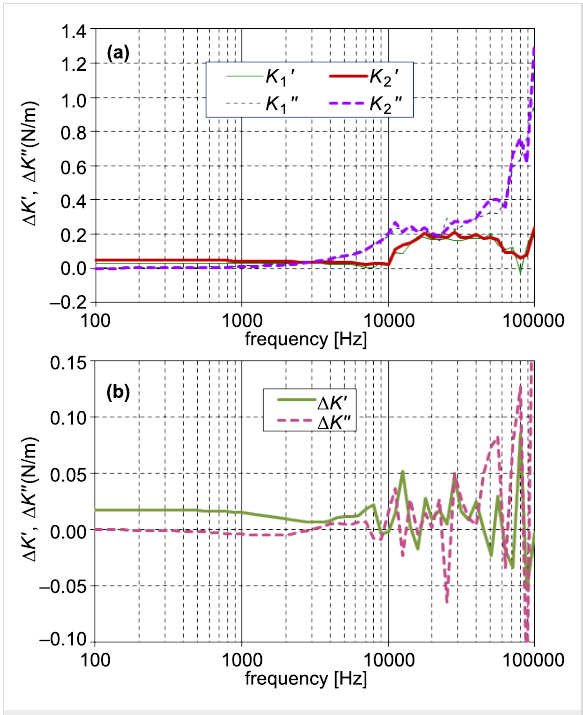
Figure 7b. It is probable that the apparent onset in at 10 kHz is actually the point at which the signal reaches a measurable level. For a decisive conclusion a more refined measurement is indispensable.